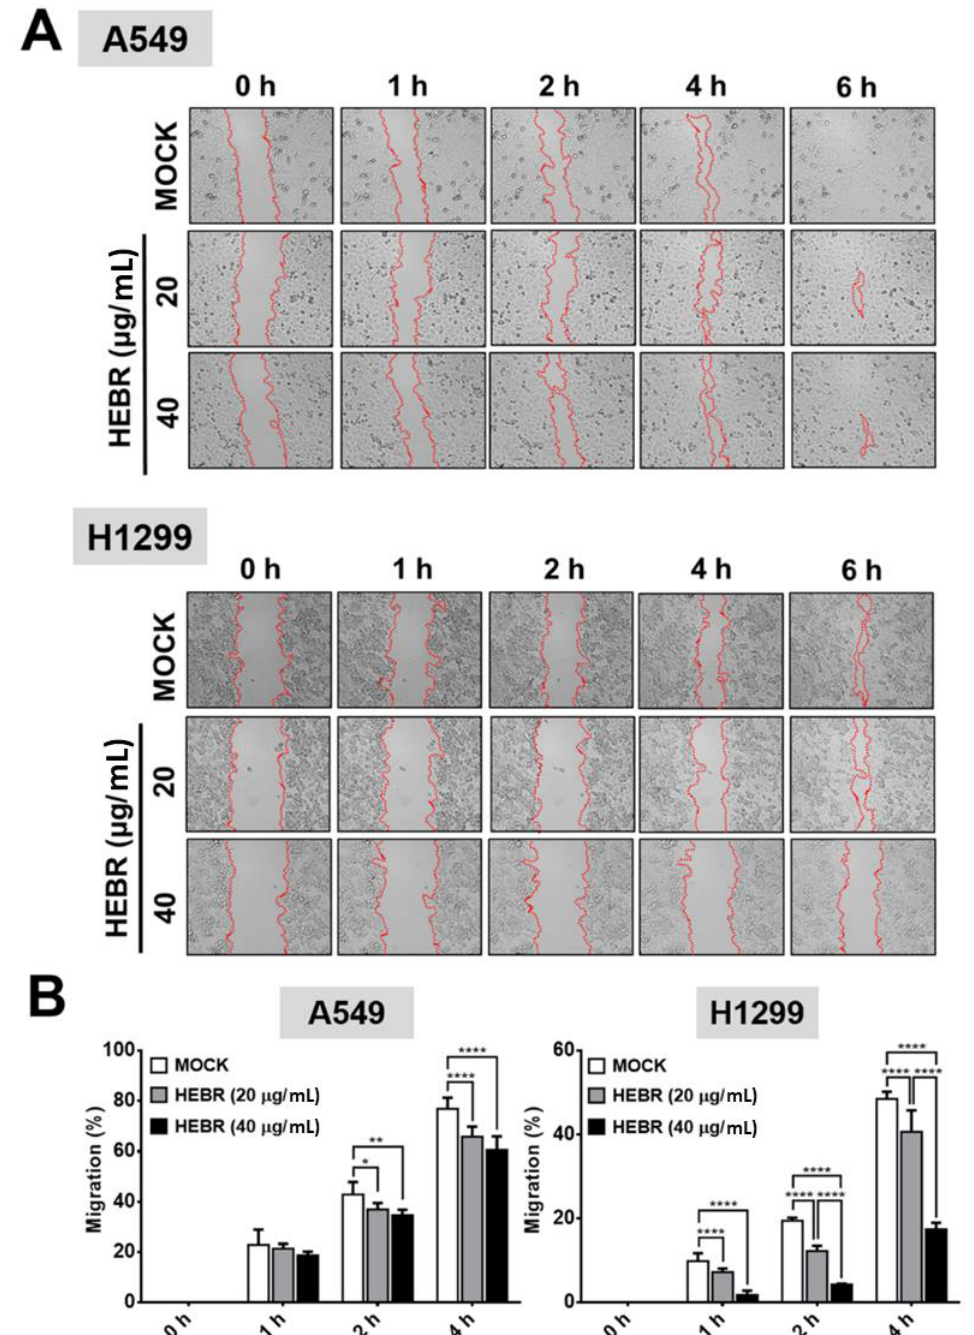
Figure 3. Inhibition of cell migration by HEBR for A549 and H1299 cells. To determine the effect of HEBR treatment on cell migration, a confluent monolayer of A549 and H1299 cells was scratched and then treated with HEBR (20 μg /mL or 40 μg /mL). After 6 h, the scratched area was observed, demonstrating subsided migration ability upon the treatment of HEBR. ( A ) The migration rate of A549 and H1299 treated with HEBR protein were recorded at 0 h, 1 h, 2 h, 4 h, and 6 h. ( B ) The area of migrated cells to the wound sides was evaluated. The percentage of cellular migration was calculated using the following formula: [(Area 0 h − Area determine h)/Area 0 h] × 100. The percentage of migration ability was calculated by GraphPad Prism 5 software. Data are presented as means ± SD. (n = 5); asterisks indicate statistically significant differences, * p ≤ 0.05, ** p ≤ 0.01, **** p ≤ 0.0001.